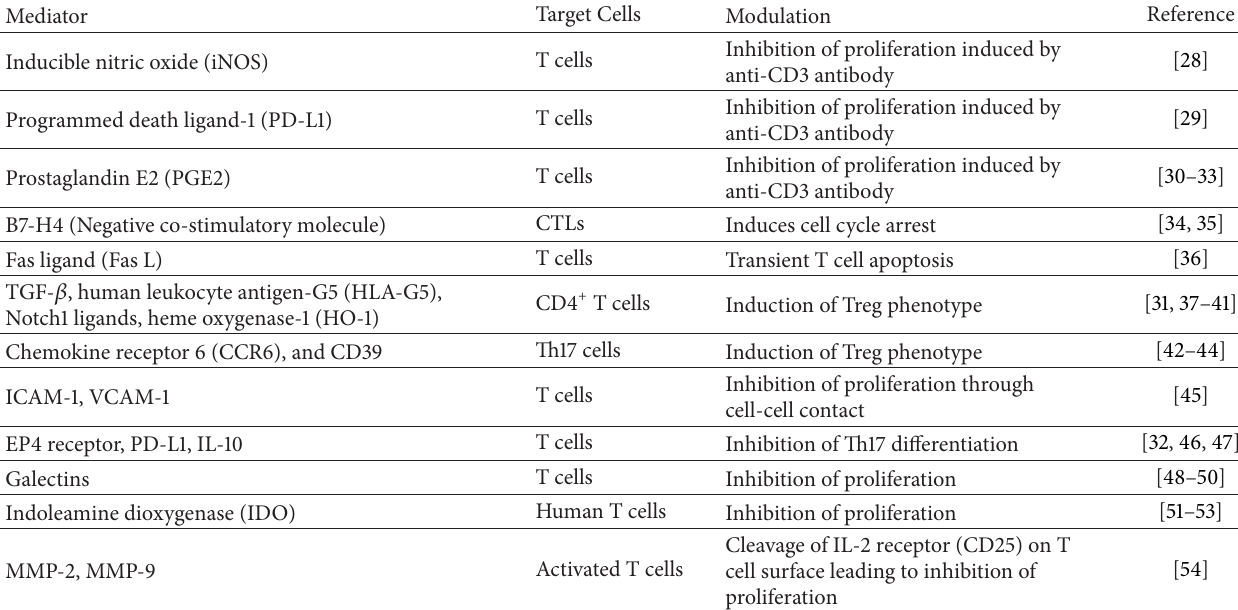
Table 1: List of mediators MSCs use to modulate proliferation and function of T